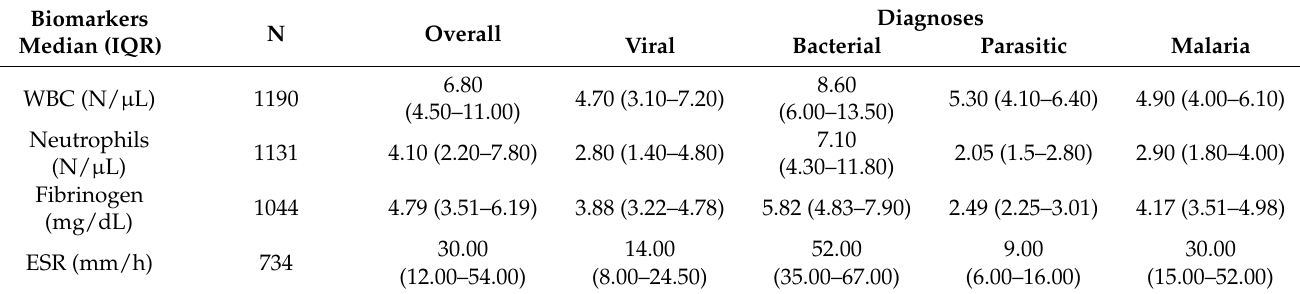
lower than those found for bacterial infections ( p < 0.0001). The median values (and infections, are reported in Table 4. infections, are reported in Table 4. Table 4. Median values of other Table 4. Median values of other biomarkers .